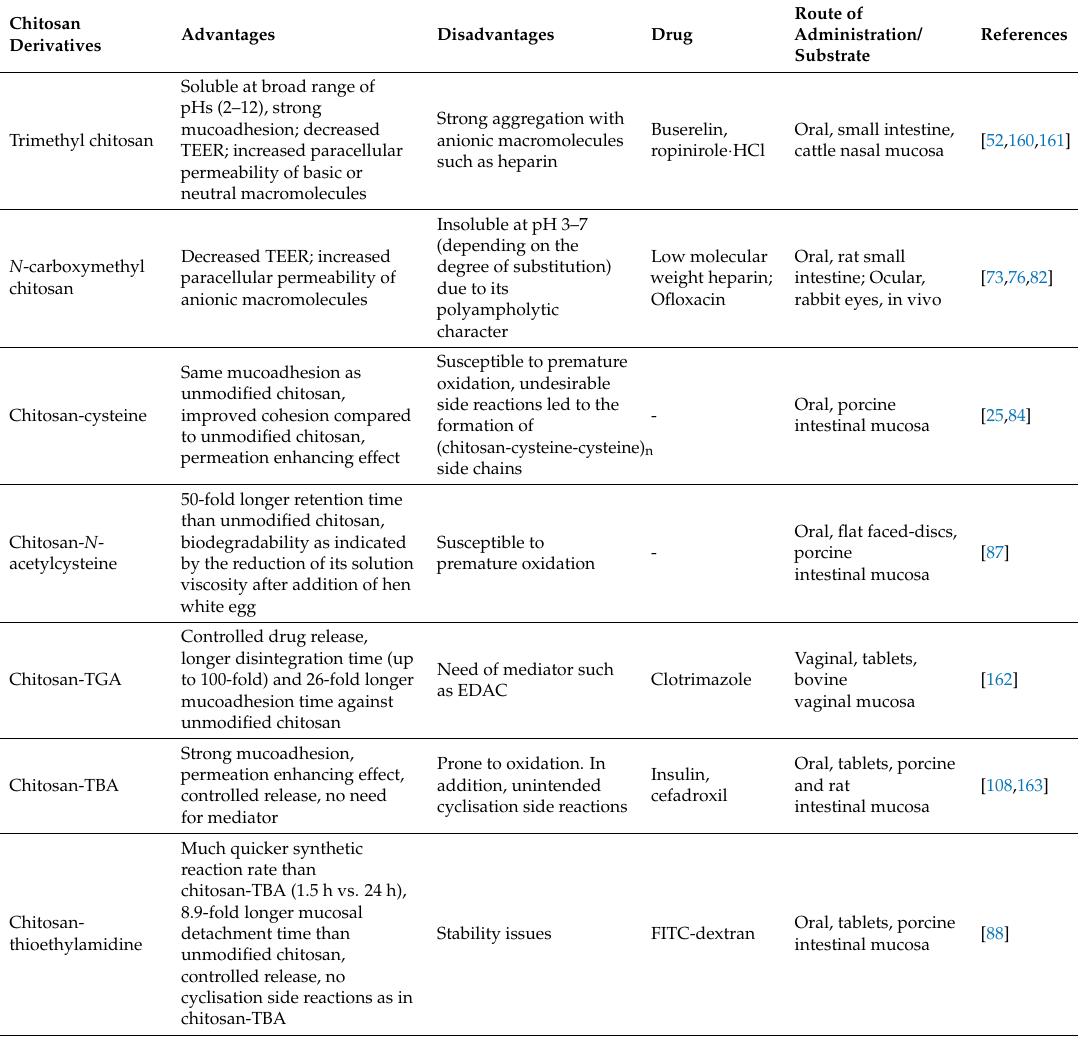
Table 1. A summary of chitosan derivatives properties with examples of drug candidates used in the mucoadhesive drug delivery